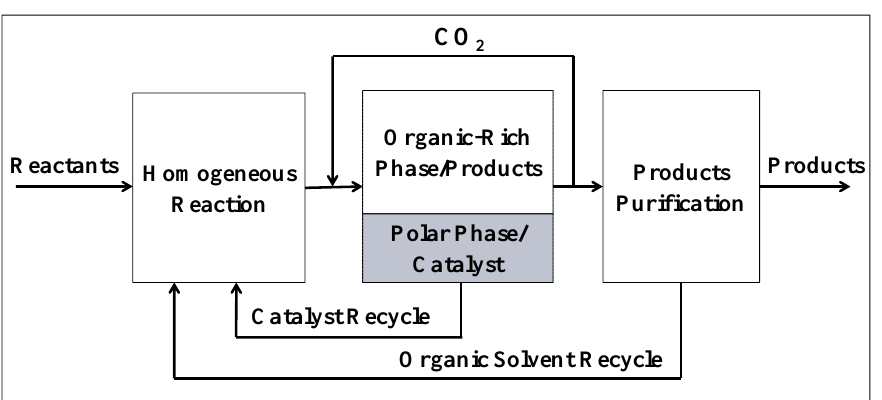
Figure 2. Schematic of an OATS Process.